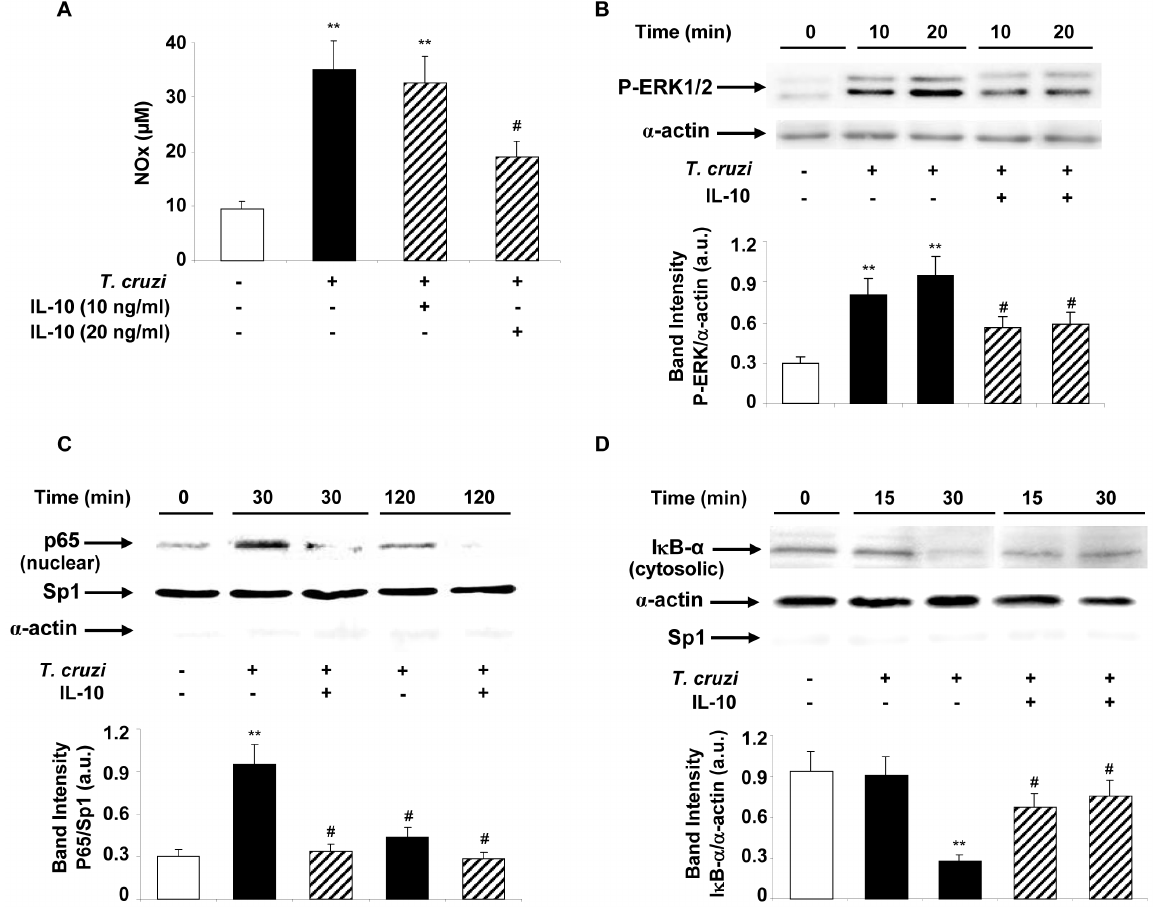
Figure 1. IL-10 inhibits cardiomyocytes inflammatory response induced by T.cruzi infection. (A) Cardiomyocytes were pre-treated with IL-10 (10 ng/ml or 20 ng/ml) for 15 min before T. cruzi infection (with parasite:cell ratio 5:1) and NO levels were quantified by Griess reaction in the culture media after 48 h (n=3). (B) Neonatal cardiac cells were infected for 10 and 20 min or pre-treated for 15 min with 20 ng/ml of IL-10 and cytosolic extracts were prepared. The levels of P-ERK1/2-MAPK were determined by Wb with specific antibodies. (C) Cells were pre-treated with IL- 10 in the same conditions as in B and infected with T. cruzi during 30 or 120 minutes for p65 nuclear detection or (D) pre-treated with IL-10 and infected for 15 or 30 min for cytosolic detection of I k B- a . For NO measurement, results are expressed as mean 6 SD (n=4). For B, C and D results show a representative experiment of three performed and protein levels were normalized against a -actin (B and D) and Sp1 (C). Mean 6 SD (n=3). **p , 0.01 vs. control cells; # p , 0.05 vs. T. cruzi infected